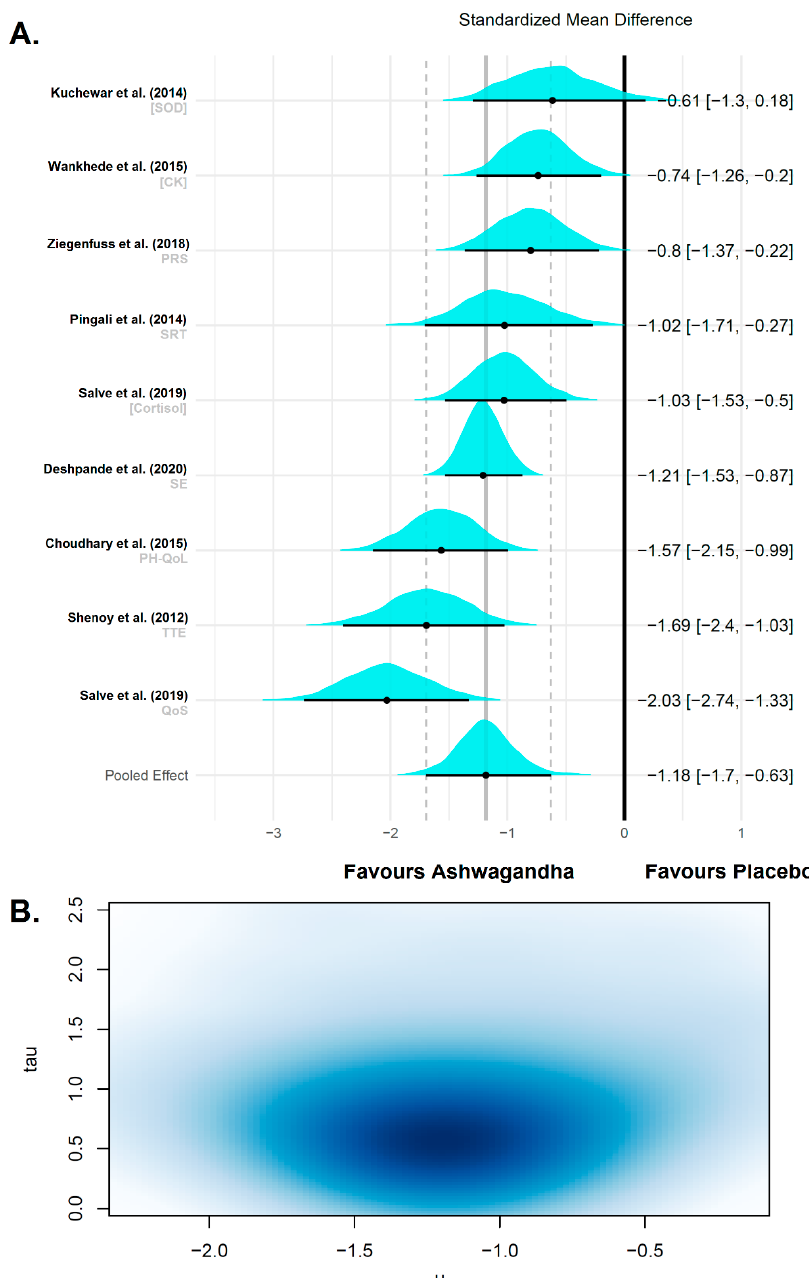
Figure 9. Forest plot of a random effect meta-analysis on fatigue/recovery variables after Ashwagandha supplementation. ( A ) The plot shows the names of the studies with their respective variable or multiple comparison/multiple outcomes on the left. On the right are the θ k and 95% CrI. The value of the overall weighted mean of effect sizes is drawn as a vertical line in the middle of the plot, which represents the reference line to test the null hypothesis in each study. The posterior distributions of the estimated effect sizes for each study are shown as cyan densities. The black circle represents the pos- terior mean, and the horizontal line extending from the point is the 95% CrI. The bottom row is the meta-analytic effect size ( μ ). ( B ) Multivariate kernel density estimation plot of the posterior distribution of μ (x-axis) and τ (y-axis) with the darker zone indicating increased plausibility of values.